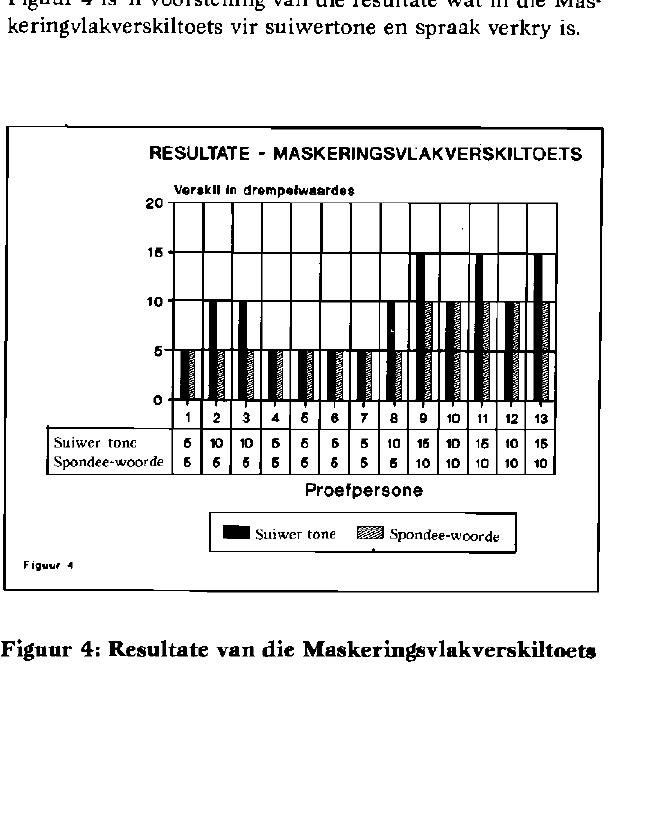
Figuur 4 is 'n voorstelling van die resultate wat in die Mas- keringvlakverskiltoets vir suiwertone en spraak verkry is.